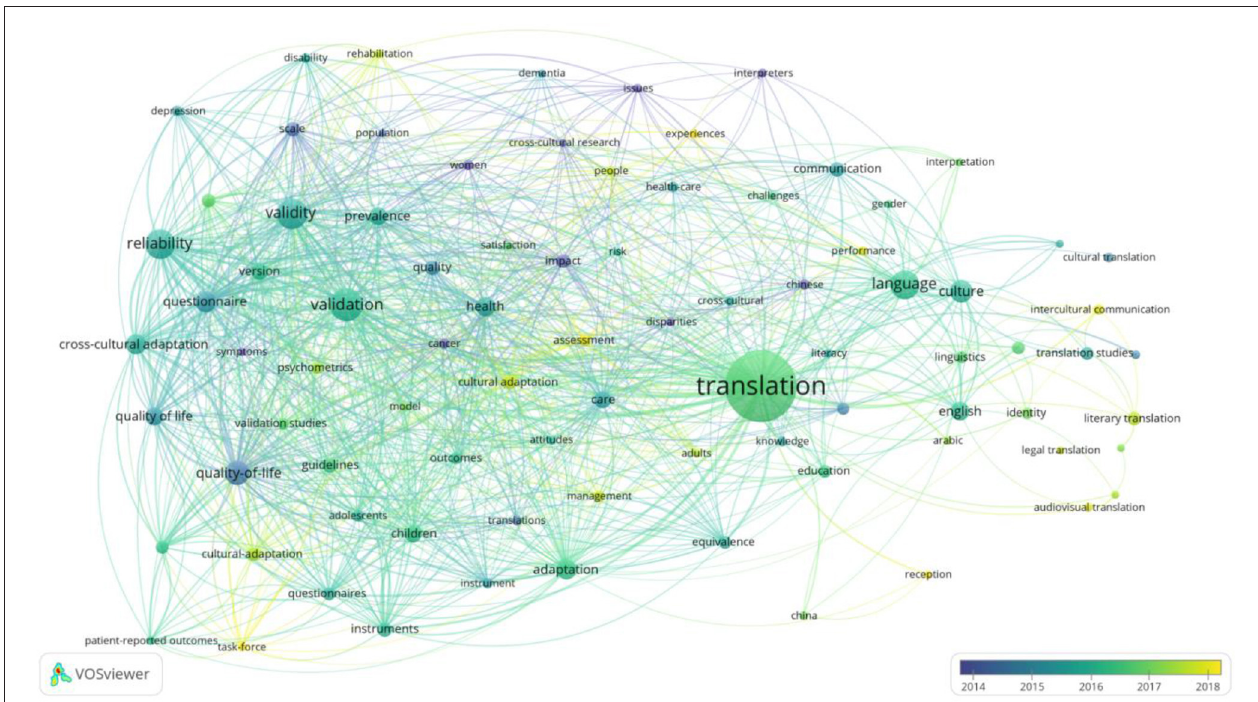
FIGURE 1 | Bibliometric analysis keywords “Neuroliguitic*” “Translat*”